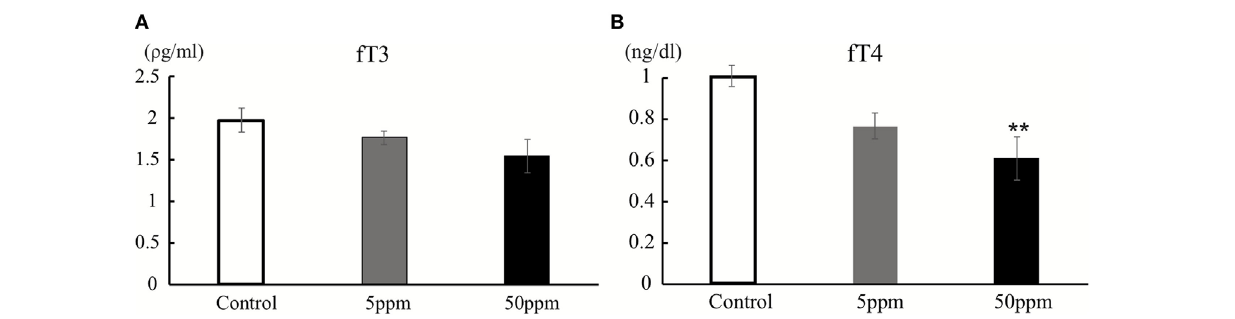
FigUre 2 | Thyroid hormone levels at postnatal day 70. Free T3 (fT3) (a) and free T4 (fT4) (B) were measured by CMIA (see text for details). There was a significant difference in fT4 levels between the control and 50 ppm group (Data are mean ± SEM, ** p < 0.01, compared to the control group by Bonferroni test).